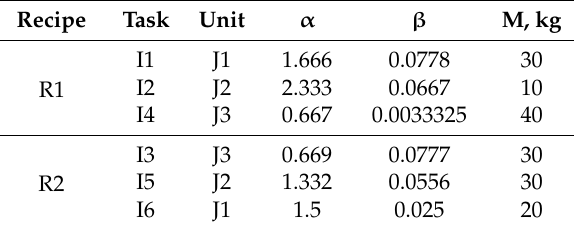
Figure 6. Recipe network for Example 2. Table 2. Key process parameters for Example